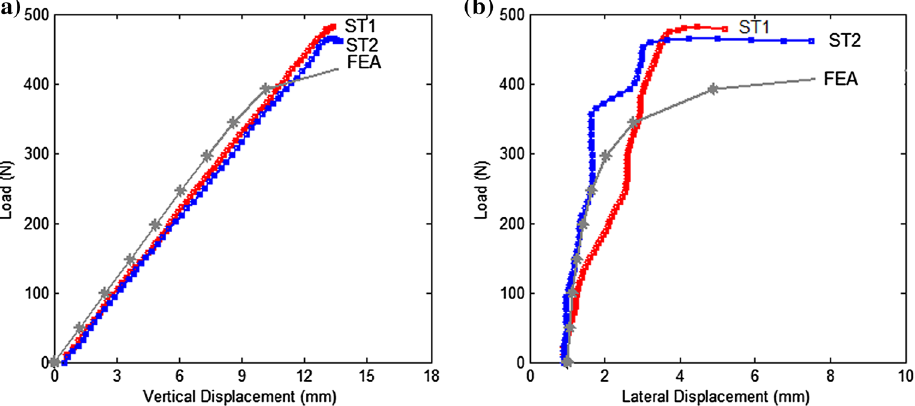
Fig. 12 Variations in the a vertical and b lateral displacements at the shear center of the beam at the mid-span from the experiments (ST1 and ST2) and finite element analysis